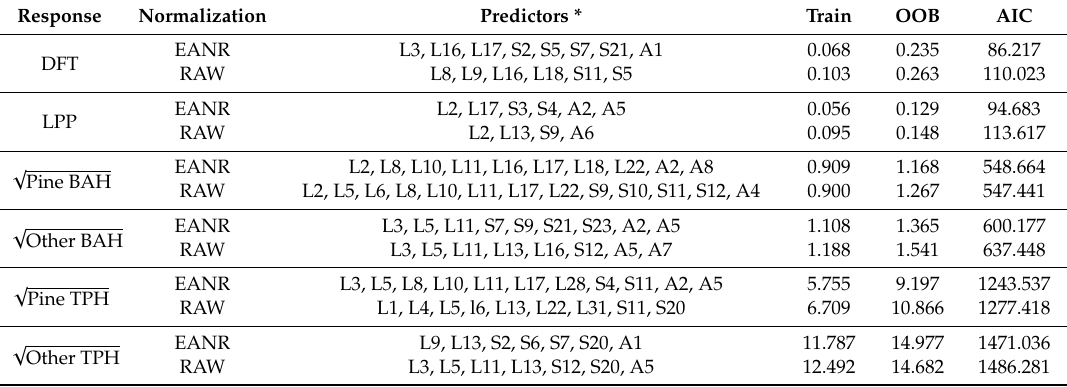
* Predictor variable naming convention is based on the concatenation of Table 1 Code and Id columns.